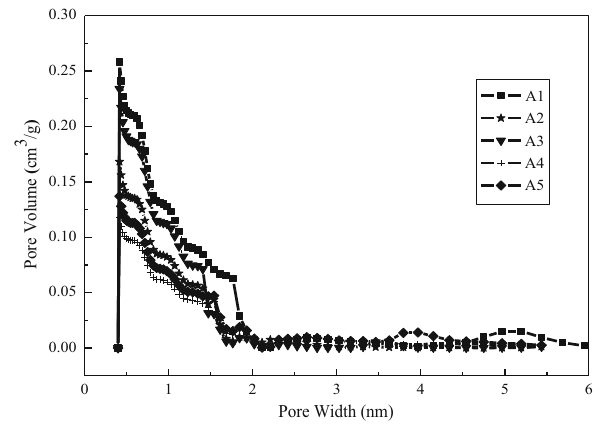
Fig. 2 Pore size distribution of the activate coke samples